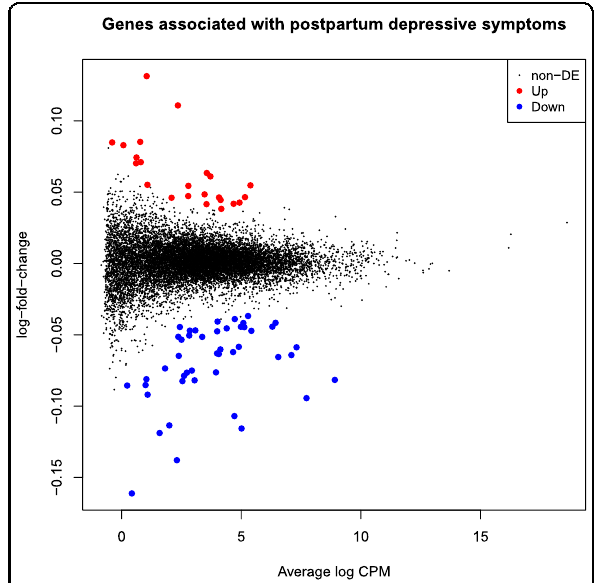
Fig. 1 Differentially expressed genes in PPD. MA plot showing up and downregulated genes associated with depressive symptoms at 2 months